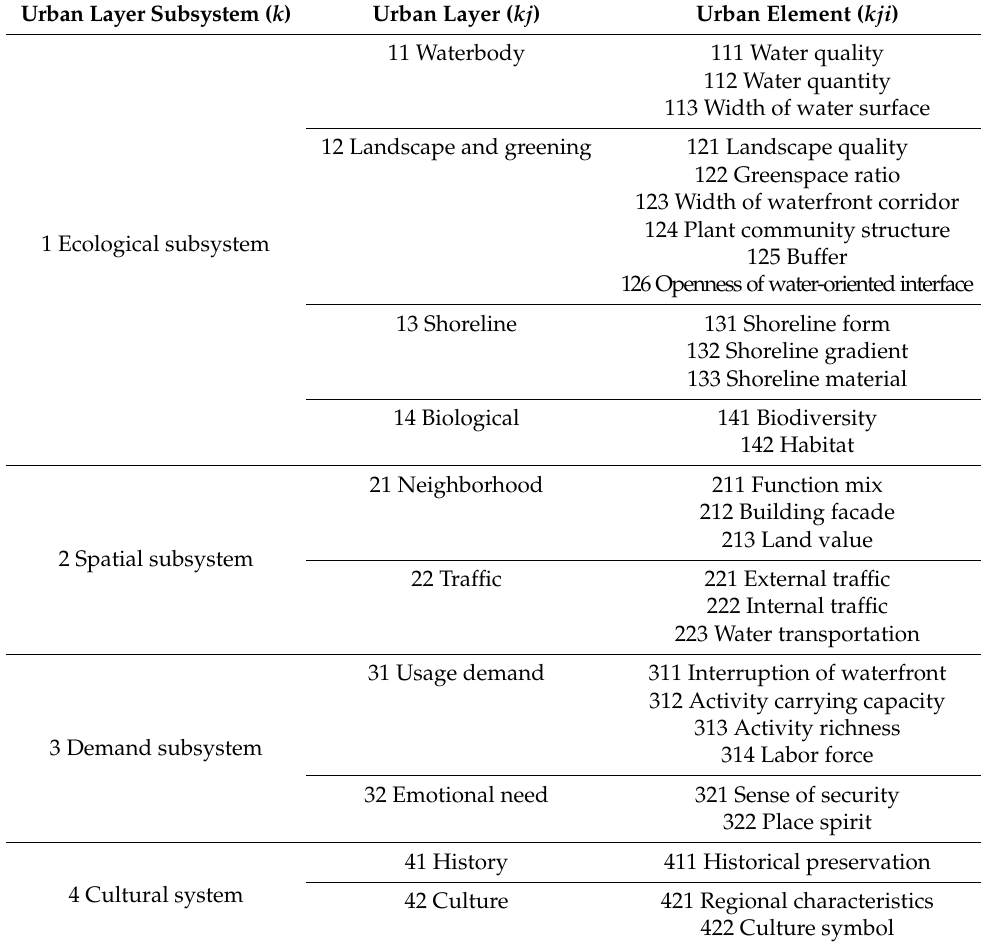
Table 3. The framework of urban layer system.